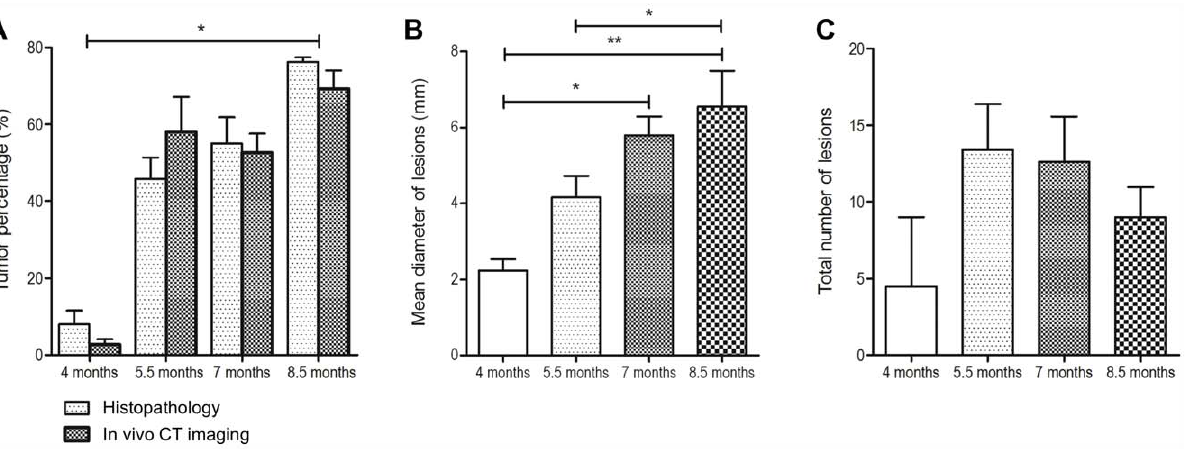
Figure 2. Time dependent changes in tumor growth of NDEA-treated c-Myc transgenic mice. (A) The organ and tumor volume was assessed by CT and by histopathology. Depicted is the percentage tumor volume at different stages measured either by histopathology (light gray) or by contrast enhanced CT imaging (dark gray). The mean diameter of lesions (B) and the total number of lesions (C) are shown. *p , 0.05. **p , 0.01.